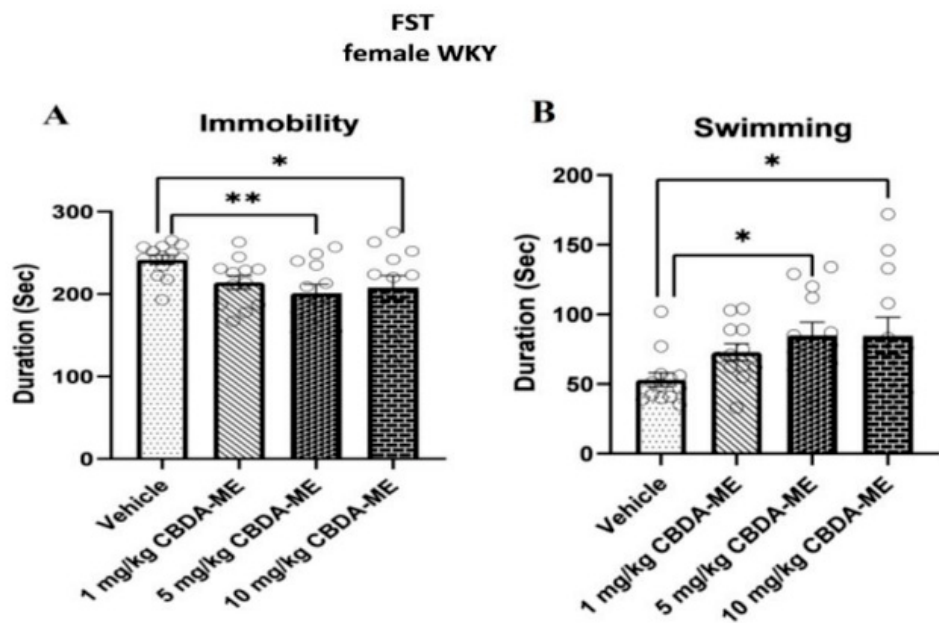
Figure 4. ( A ) Duration of immobility (mean + SEM) of female WKY rats ( B ) Duration of swimming (mean + SEM) of female WKY rats. Rats ingested either vehicle (n = 13) or 1 mg/kg CBDA-ME (n = 12), 5 mg/kg CBDA-ME (n = 12), 10 mg/kg CBDA-ME (n = 12). ** p < 0.01, * p < 0.05. Corticosterone levels in